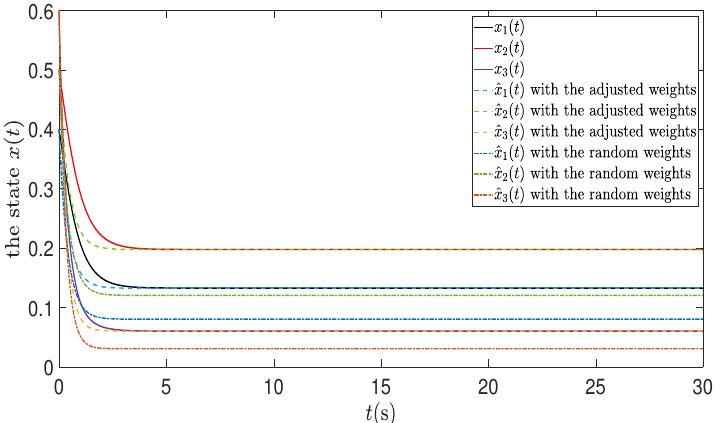
Figure 19. The state and estimated state with the adjusted weights and state with the random weights curves.